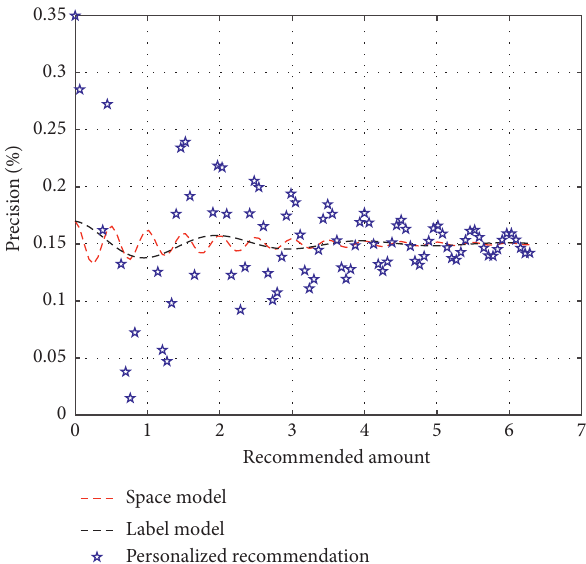
Figure 8: Comparison of top-n recommendation